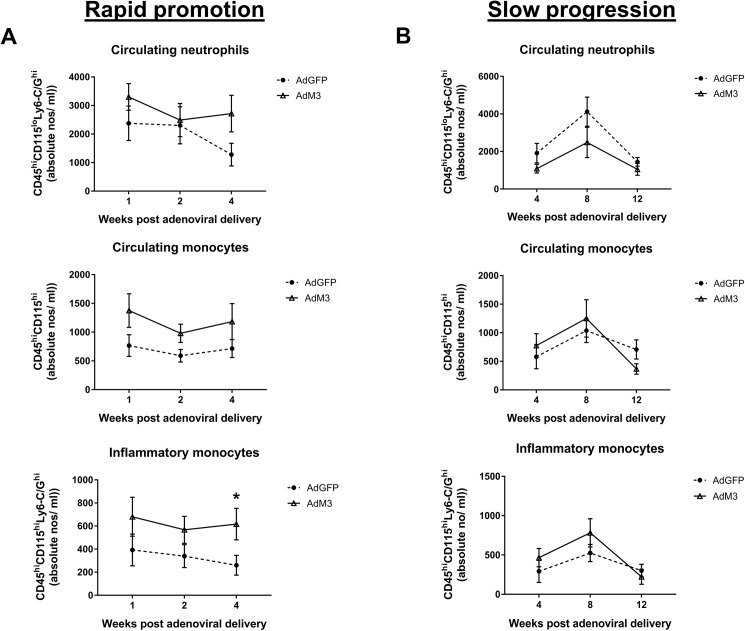
M3 prevents a decrease in inflammatory monocytes in the rapid promotion model four weeks’ post-gene transfer.Two models of ‘rapid promotion’ or ‘slow progression’ of atherosclerosis were established in which a HFD or regular chow were fed and AdM3 or AdGFP were infused (n = 7/group). See “Materials and Methods” for details. Circulating neutrophils (CD45hiCD115loLy6-C/Ghi) and monocytes (CD45hiCD115hi) were measured for Ly6-C/G by flow cytometry every week up to 4 weeks in A. the ‘rapid promotion’ model and every month up to 12 weeks in B. the ‘slow progression’ model.